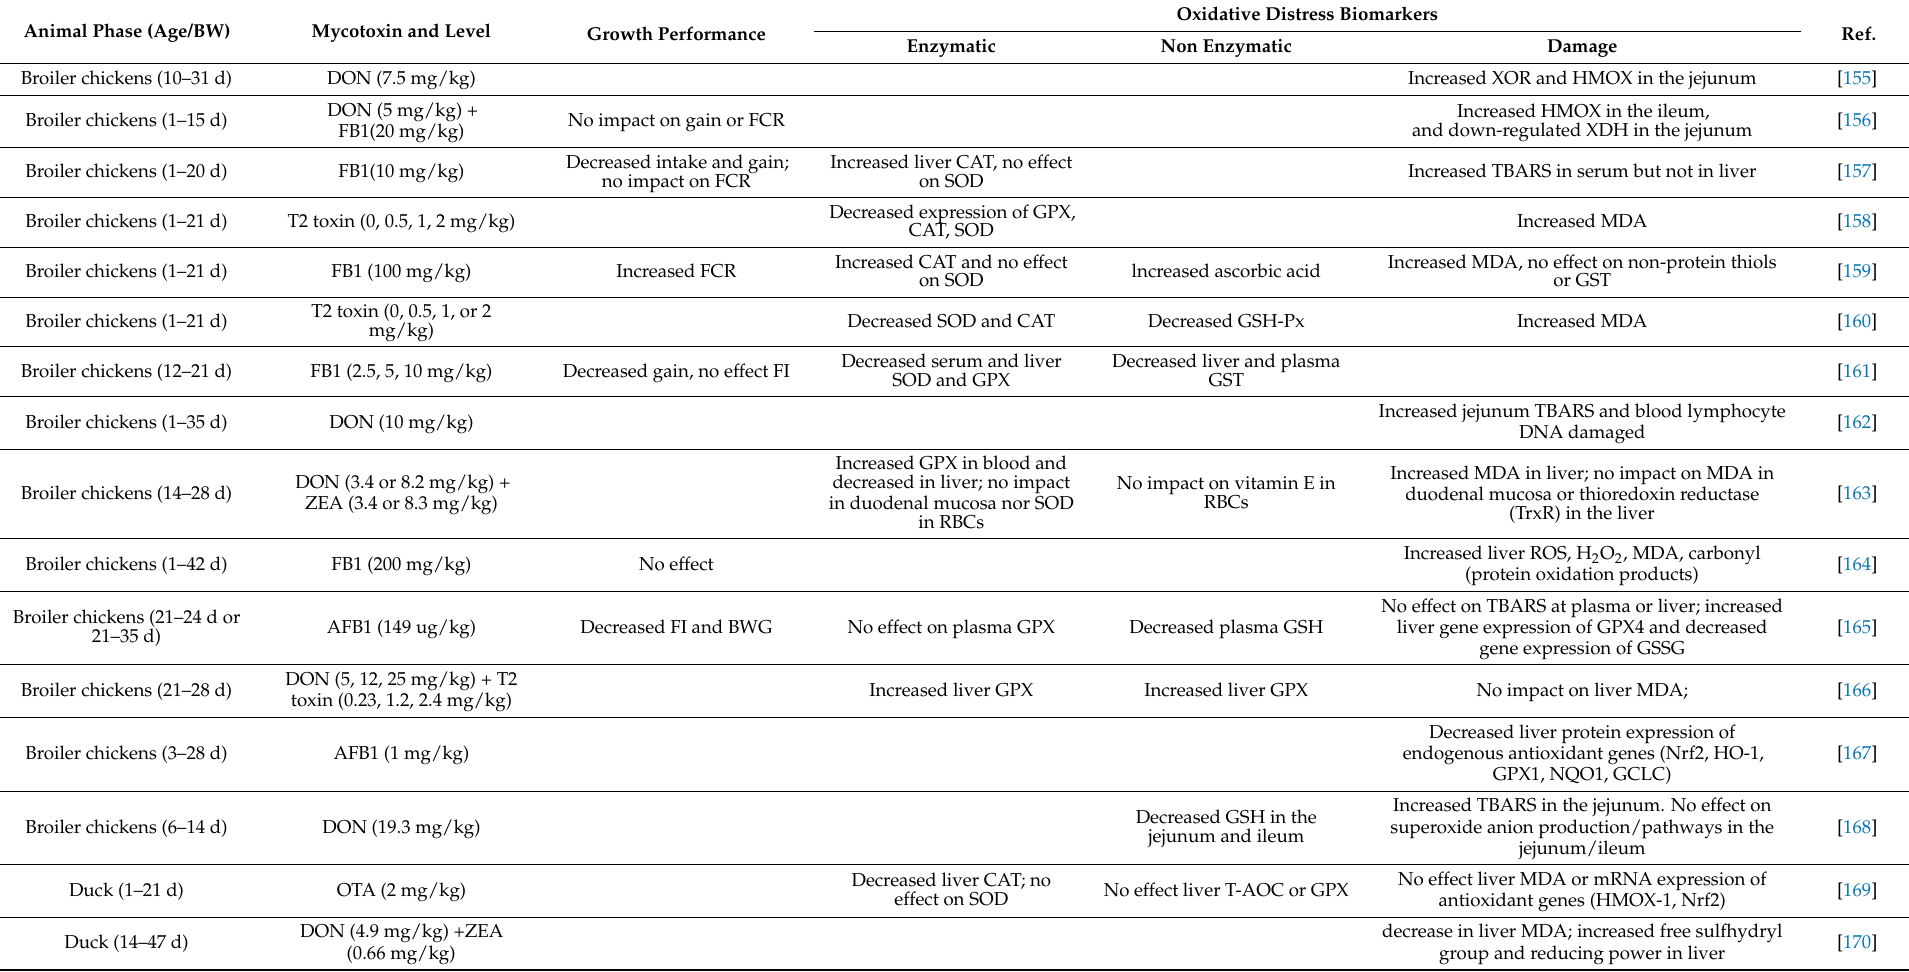
Table 6. Summary of the dietary oxidative challenges models using mycotoxins in poultry, swine and fish diets, including nutrient and concentration and results, including effect on growth performance and markers of oxidative stress classified as enzymatic, non-enzymatic, or